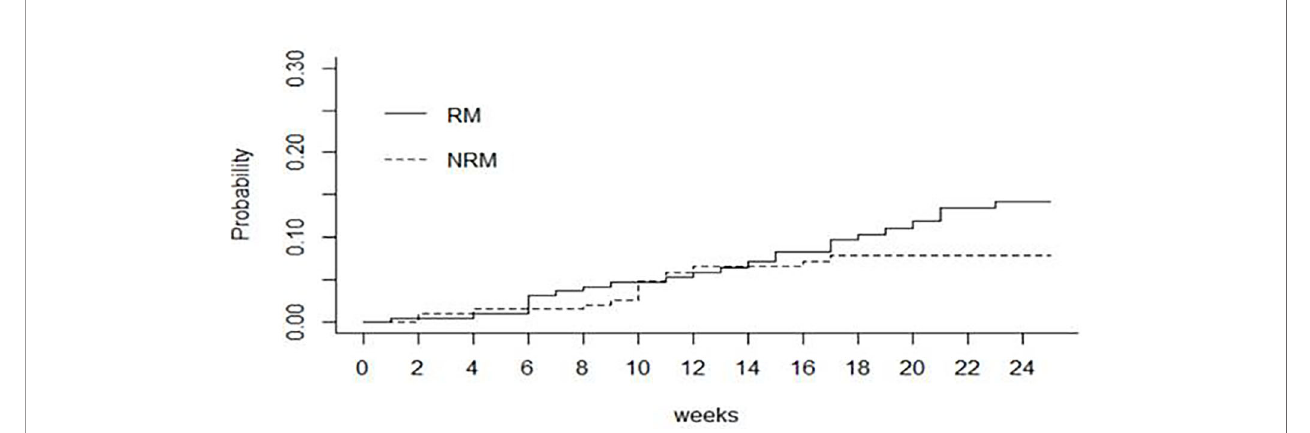
FIGURE 2 | Cumulative incidence by relapse (RM) and non-relapse mortality (NRM).